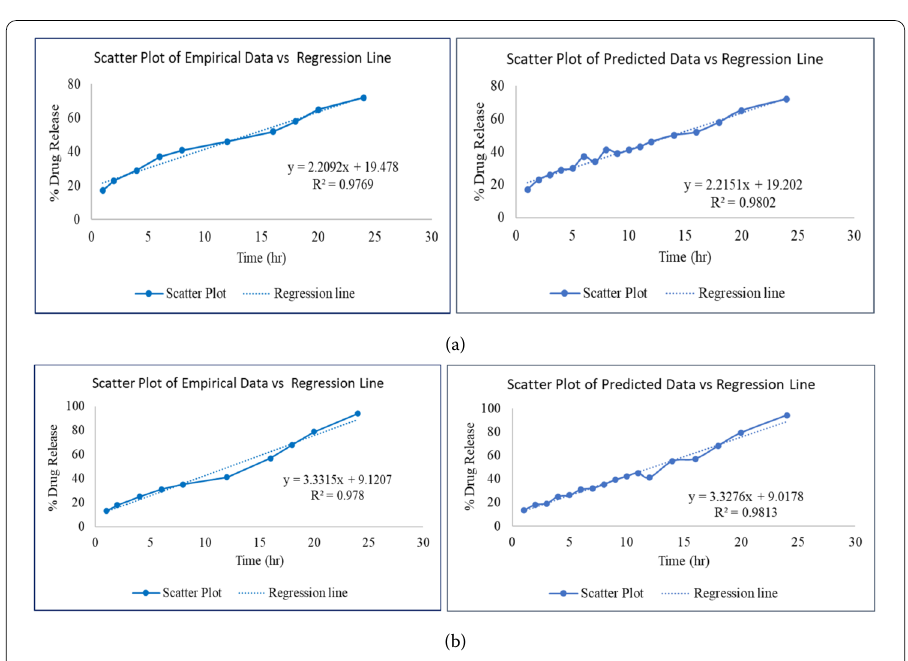
Figure 2 ( a ) Scatter plot and regression line of Venlafaxine HCl MR Tablets for formulation –1 ( X vs Y 1). ( b ) Scatter plot and regression line of Venlafaxine HCl MR Tablets for formulation –2 ( X vs Y 2)